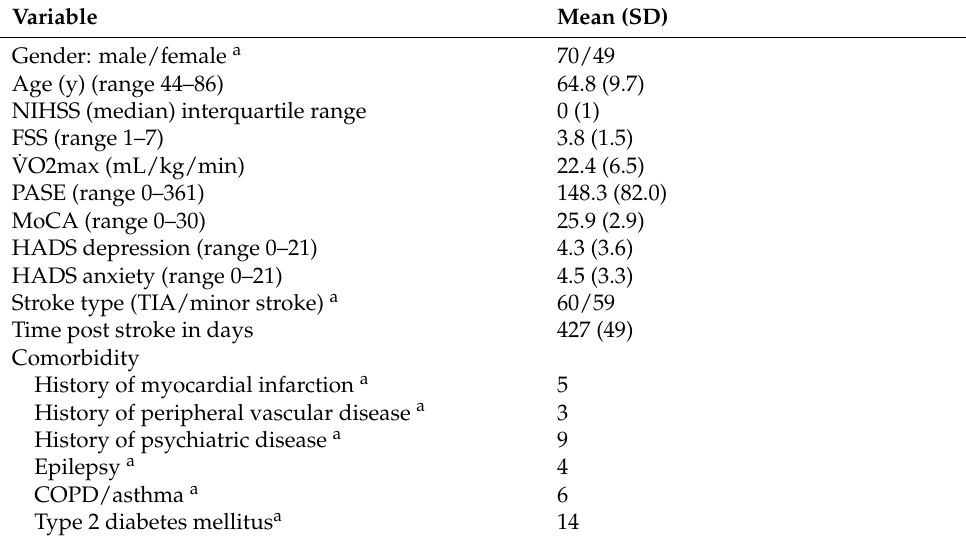
Table 1. Patient characteristics at one year post-onset (N = 119).